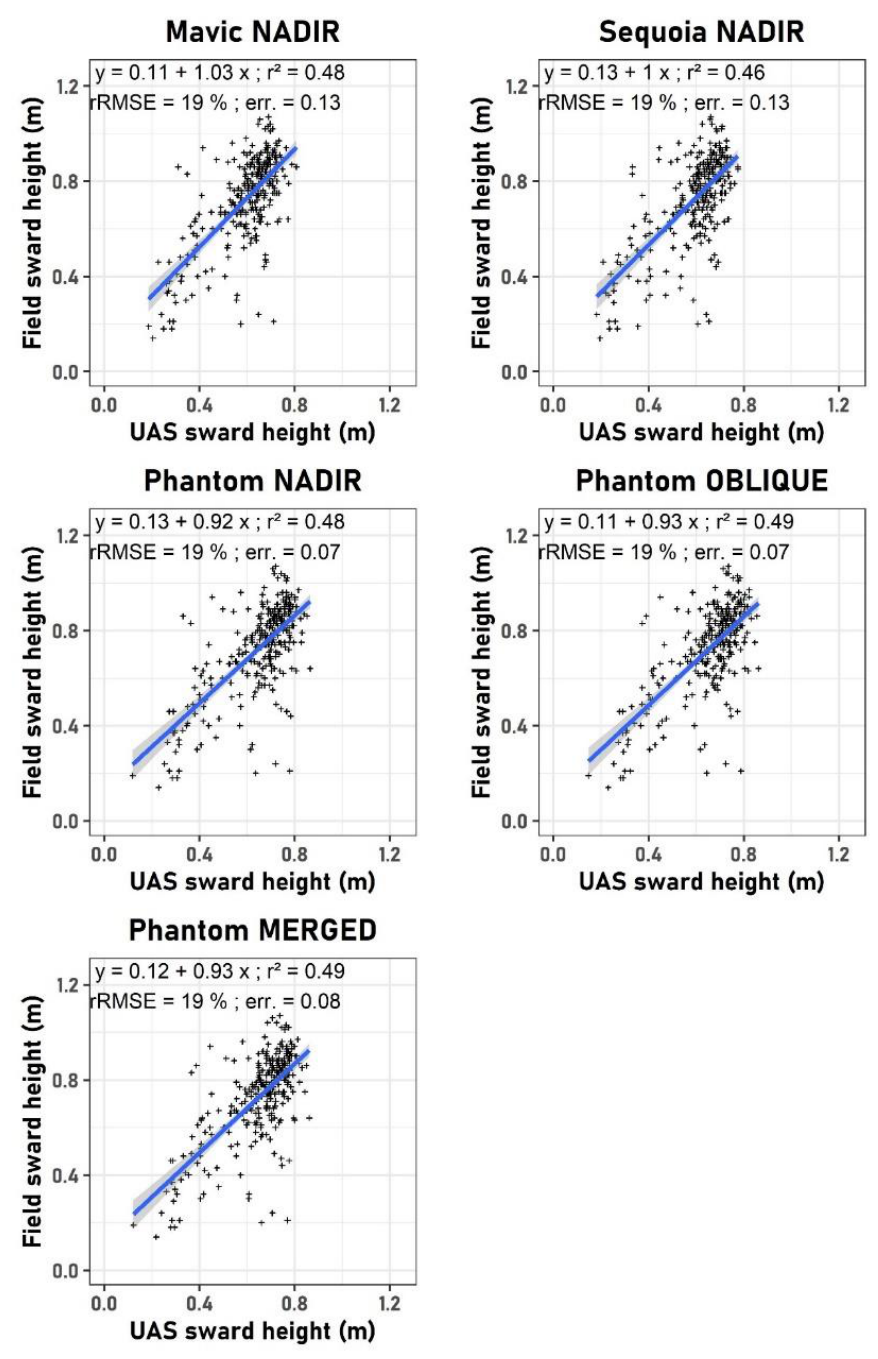
Figure 3. Biplots of sward height from UAS sward height model and from field measurements. The mean error (err.) is computed from the di ff erence between the reference field sward height and the UAS sward height. Relative root mean square error (rRMSE) is computed from the RMSE ratio with the mean field sward height measurements. The blue line is the regression line fitted over the plotted data (Model 1). The grey area around the regression line represents the 95% confidence region. When averaged at the plot scale (10.5 m 2 ), the UAS sward height estimates presented a better agreement with the field sward height averaged at the same plot scale (Figure 4). In terms of